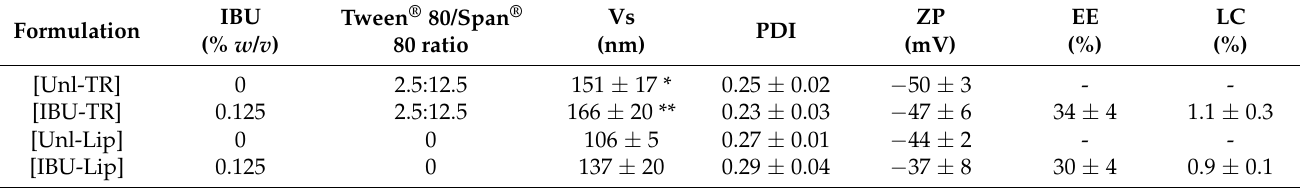
Table 5. Physicochemical properties of unloaded and IBU-loaded transfersomes (Unl-TR and IBU-TR, respectively) and liposomes (Unl-Lip and IBU-Lip, respectively) immediately after preparation.